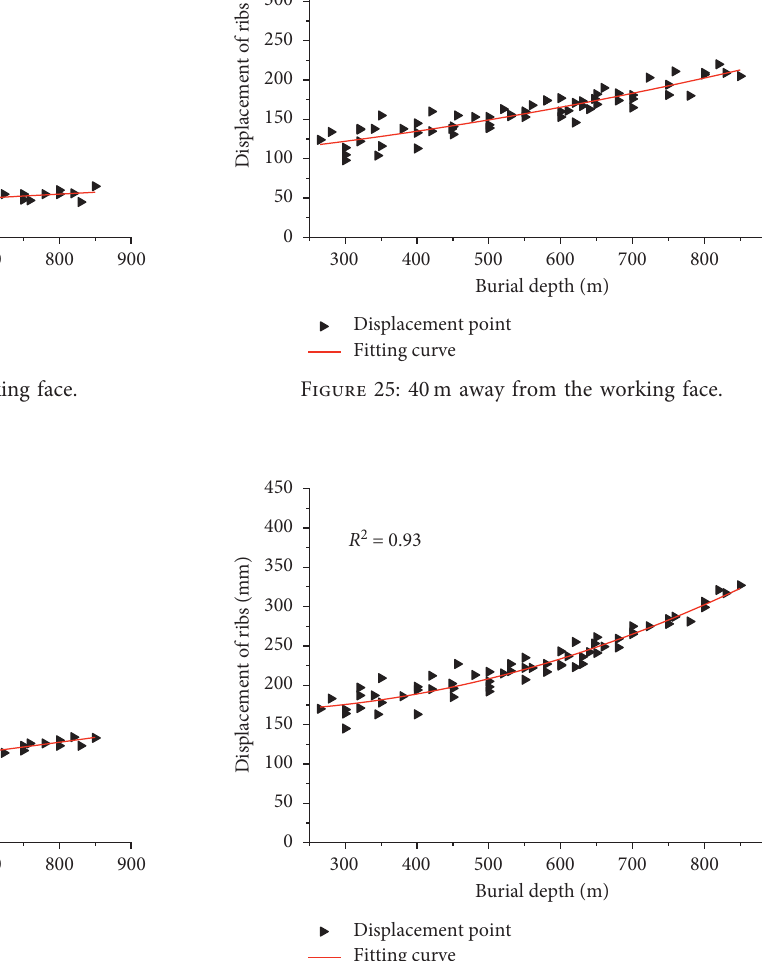
Figure 24: 60m away from the working face.